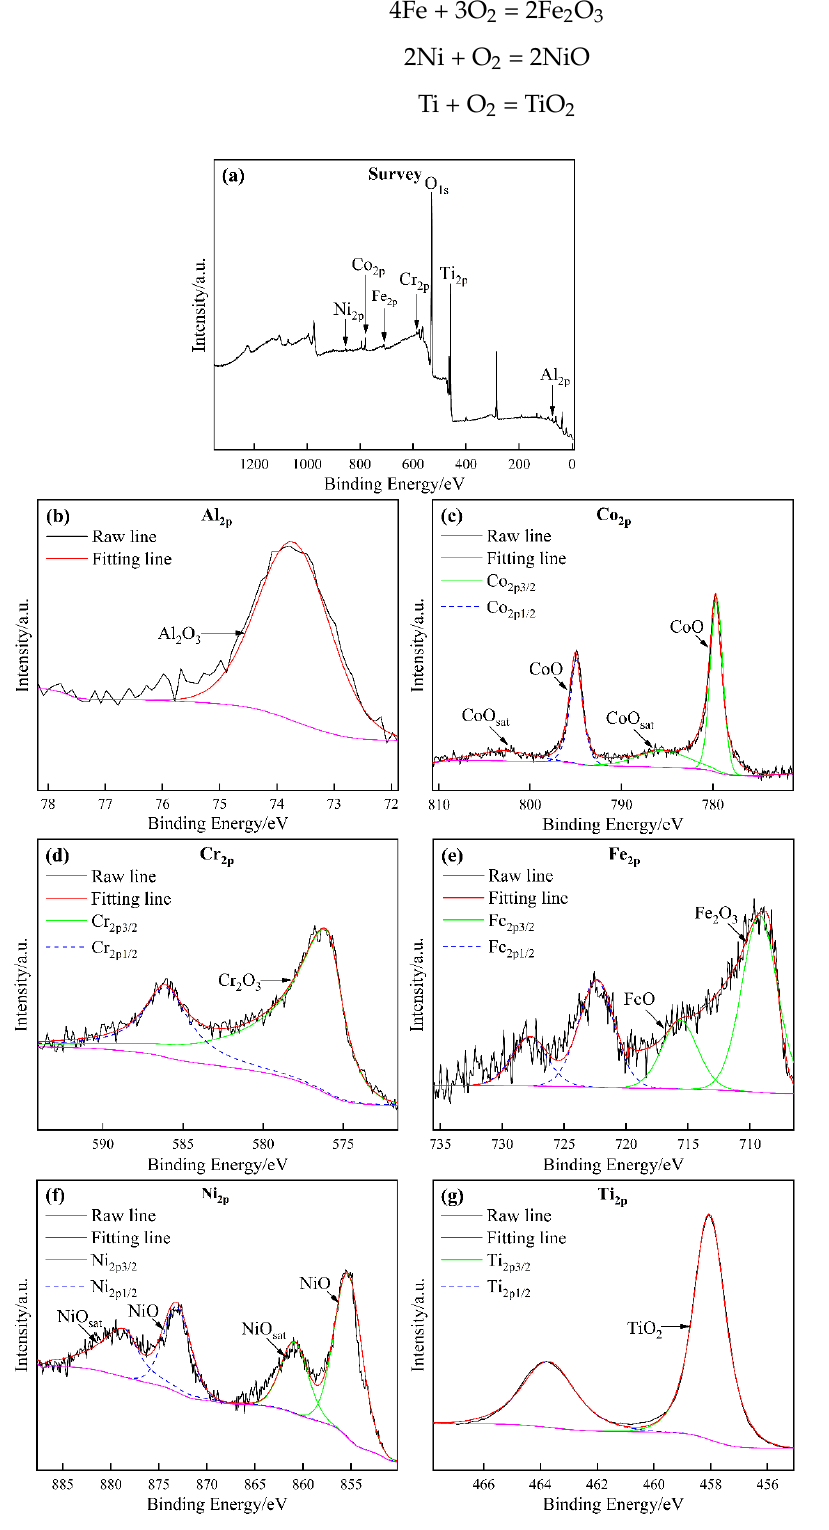
Figure 8. Fitting results of the peaks of ( a ) survey spectrum, ( b ) Al 2p , ( c ) Co 2p , ( d ) Cr 2p , ( e ) Fe 2p , ( f ) Ni 2p , and ( g ) Ti 2p recorded on the CoCrFeNiAl coating subject to the corrosion tests.